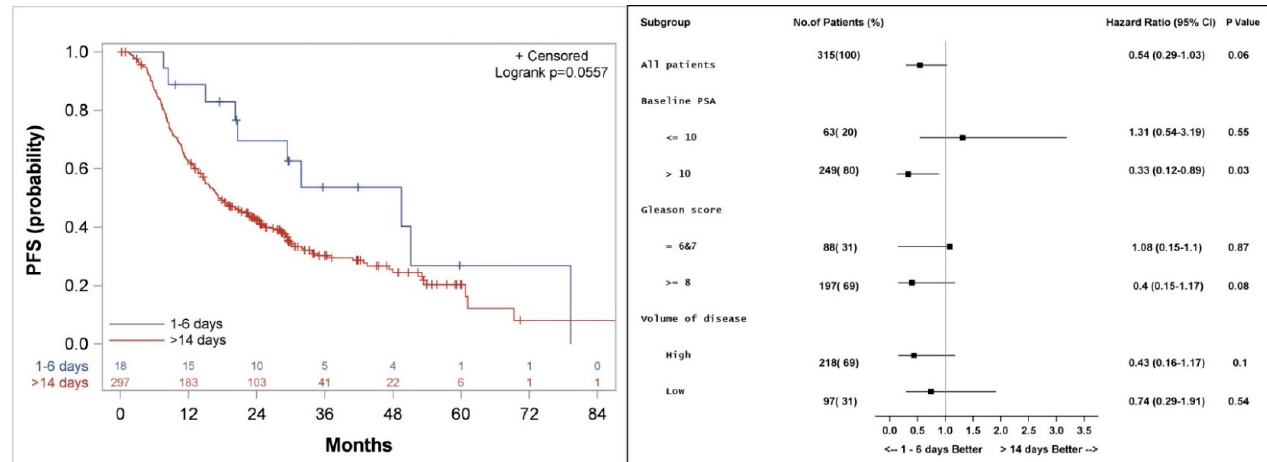
Figure 4. Kaplan–Meier curve ( left ), and subgroup analysis ( right ) for progression ‐ free survival (PFS) for patients who started the first course of docetaxel 1–6 days, compared to more than 14 days after the initiation of LHRH agonist.